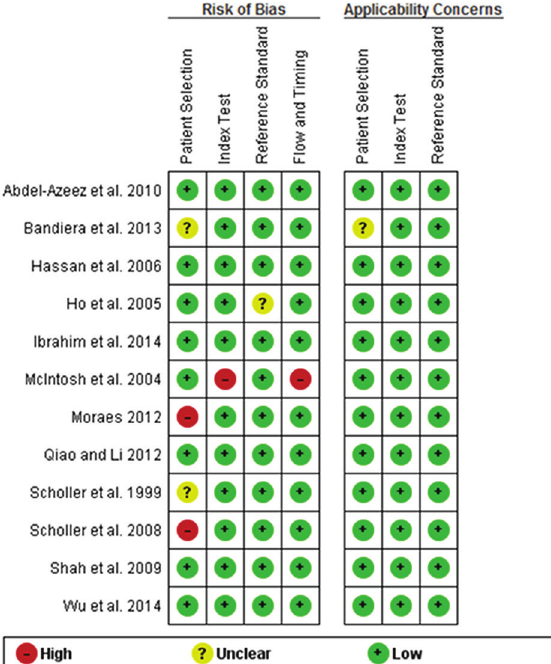
Figure 2 - Results of the evaluation of each study according to QUADAS-2. See the colors in the online